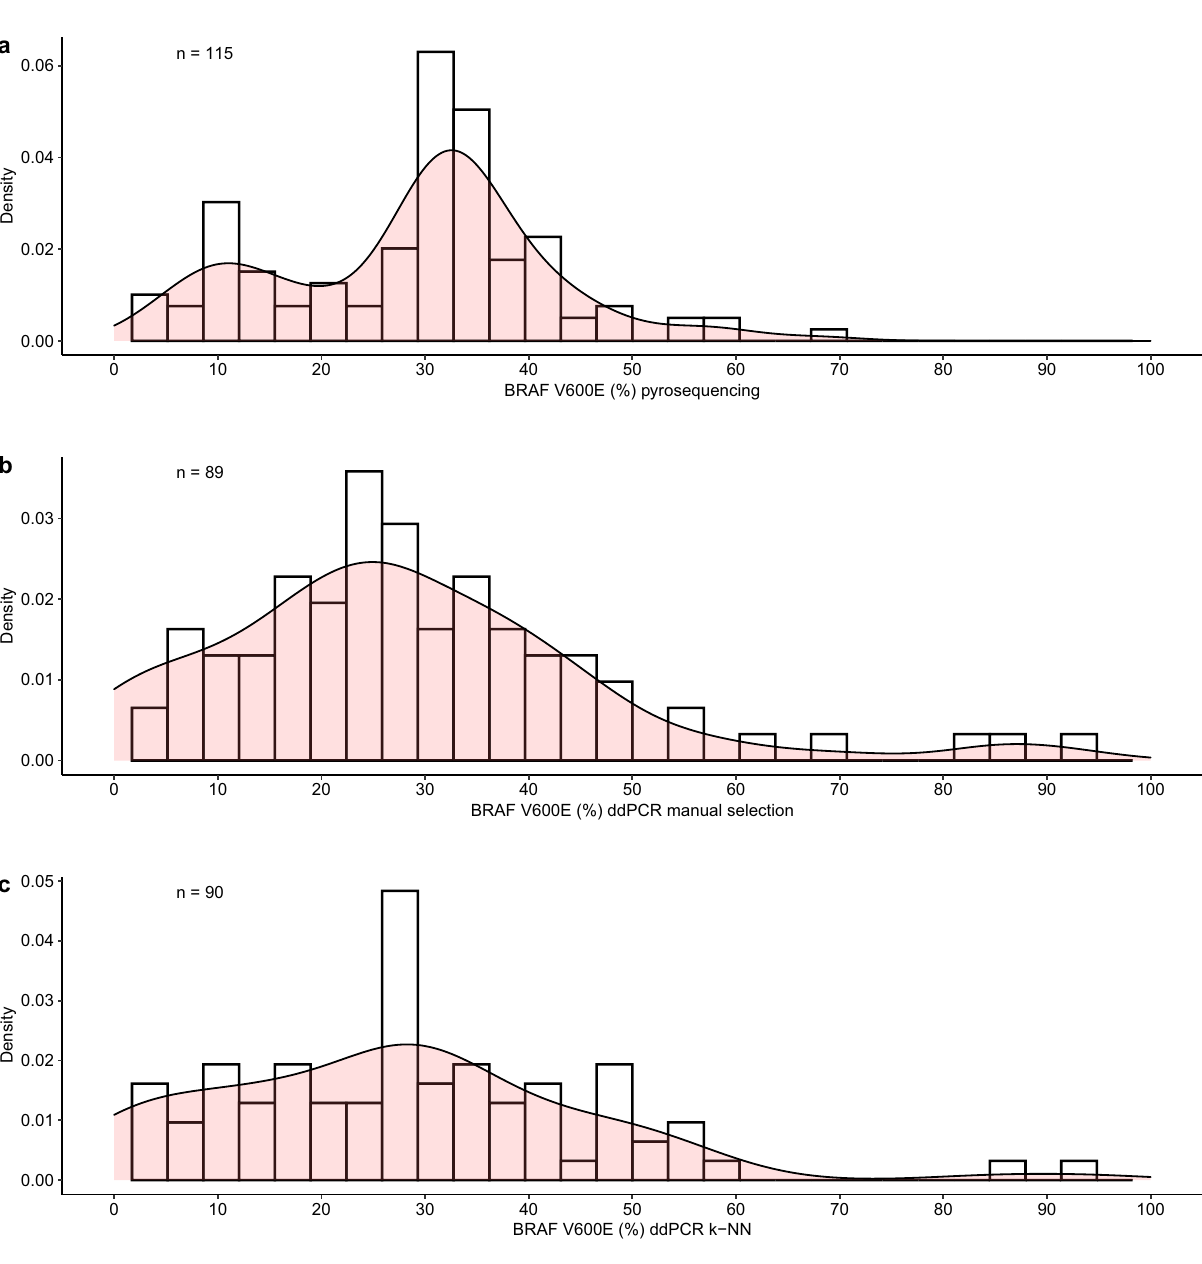
Figure 6. Distribution of percentage of BRAF V600E by using different techniques. The density plot represents the distribution of BRAF V600E percentage across all samples. It uses a kernel density estimate to show a fitted density curve. Not only, but it also shows the histogram of this distribution. ( a ) Percentage obtained through pyrosequencing. There is the formation of two populations, one with lower percentage (< 20%) with the center close to 10% and one with higher percentage (> 20%) with the center close to 34%. ( b ) Percentage obtained through manual selection excluding rain droplets in ddPCR. ( c ) Percentage obtained through k-NN selection excluding rain droplets in ddPCR. It is possible to check that for both ddPCR graphs, only one curve of distribution seems to be clearly visible. Not only, but the density curve is smoothed in k-NN values, with less extreme values close to 100% BRAF